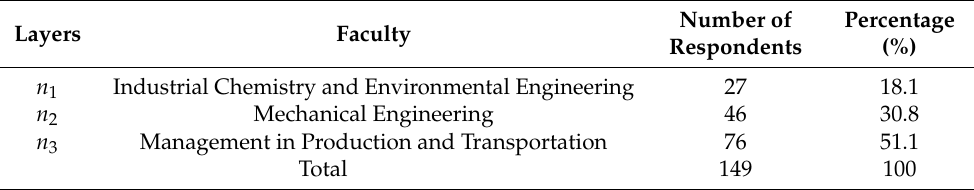
Table 1. Student